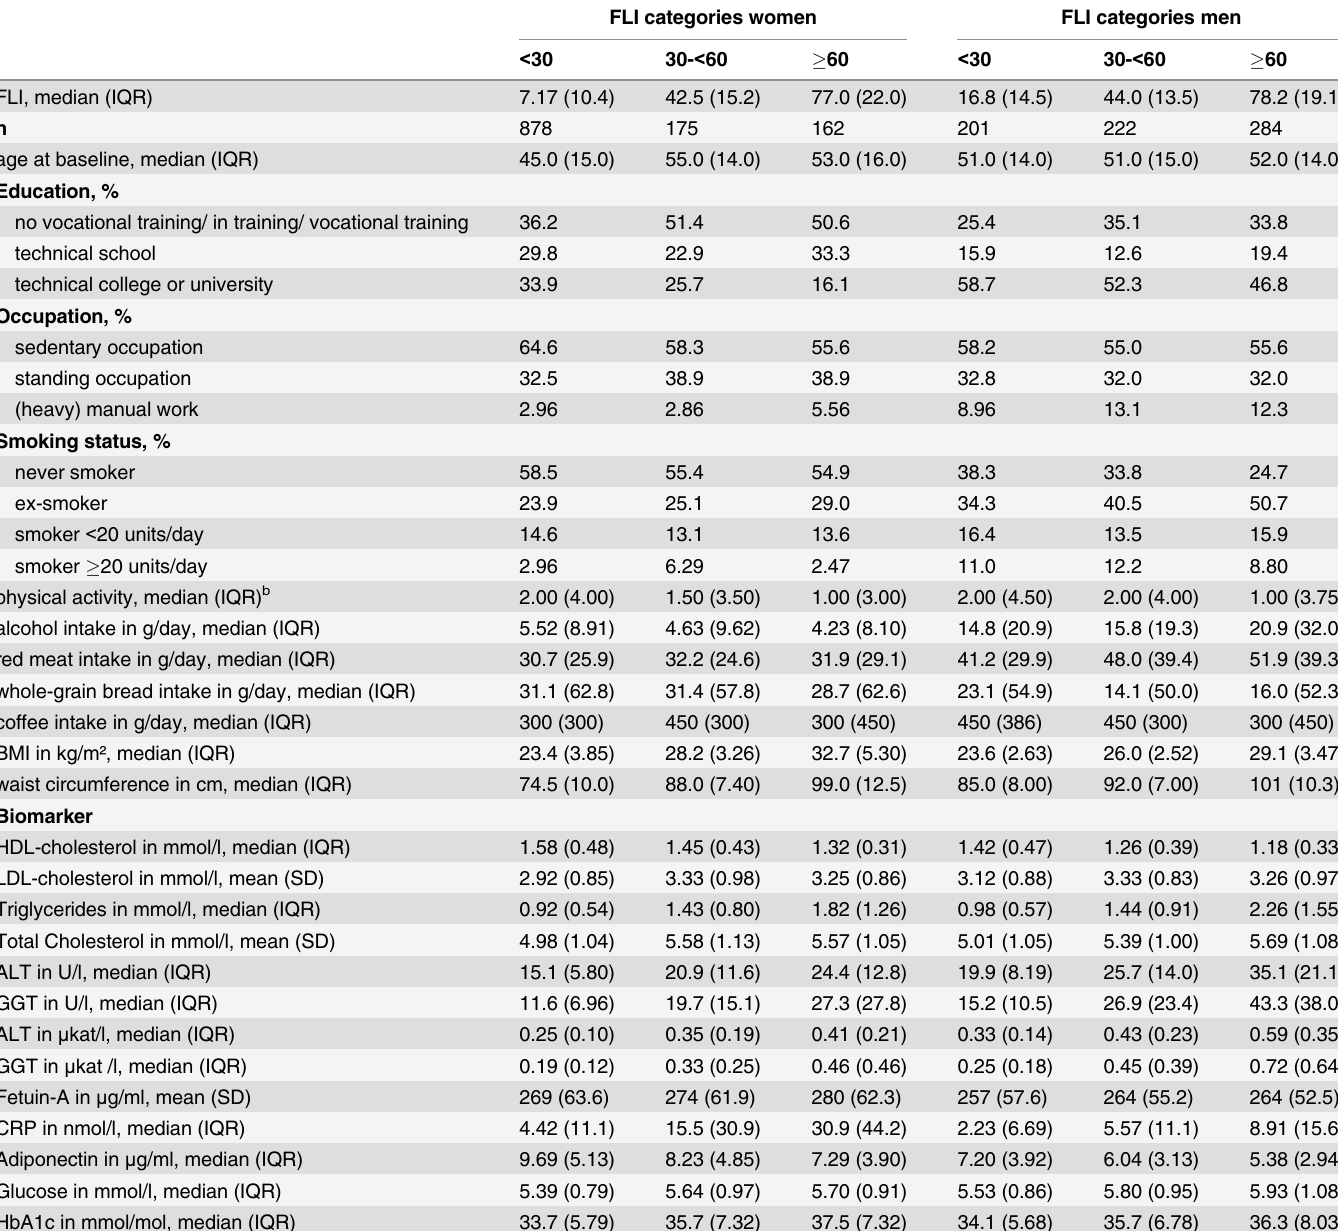
Table 1. Baseline characteristics by categories of the fatty liver index in EPIC-Potsdam a